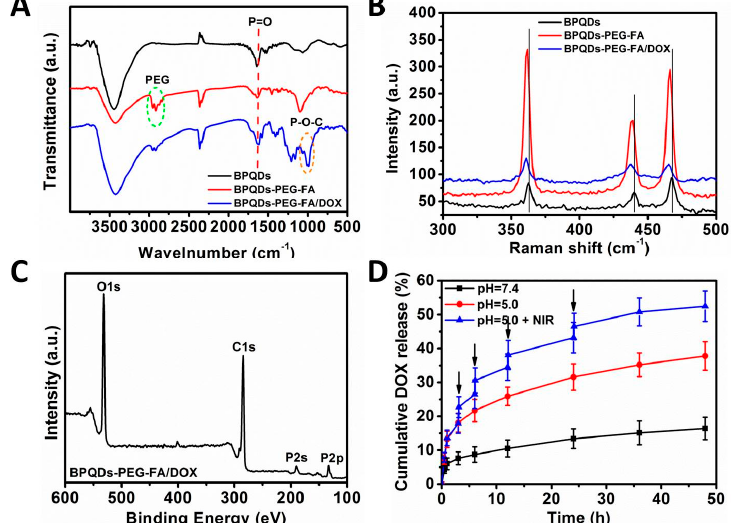
Figure 3. Characterizations of the nanoparticles (NPs). ( A ) Fourier transform infrared (FT-IR) spectrum of the BPQDs-based nanoparticles. ( B ) Raman spectra of the NPs. ( C ) X-ray photoelectron spectroscopy (XPS) spectrum of BPQDs-PEG-FA / DOX. ( D ) DOX release profiles of BPQDs-PEG-FA / DOX at di ff erent pH values with or without near infrared laser irradiation (1.0 W cm − 2 , 6 min).